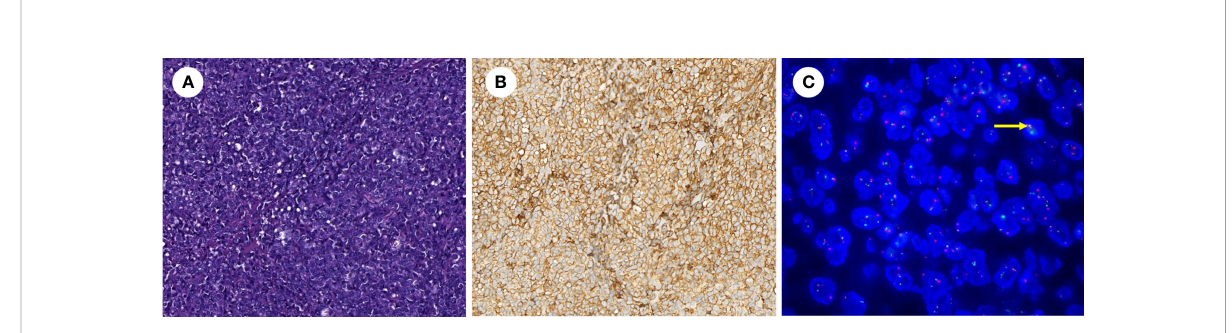
FIGURE 3 (A) Hematoxylin – eosin stain showing the mass consists of small round cells (hematoxylin-eosin, original magni fi cation ×200). (B) Immunohistochemistry revealed extremely positive CD99 staining (× 200). (C) The fusion of EWSR1 with FLI1 was positively detected by FISH in tumor cells (yellow arrow) (×